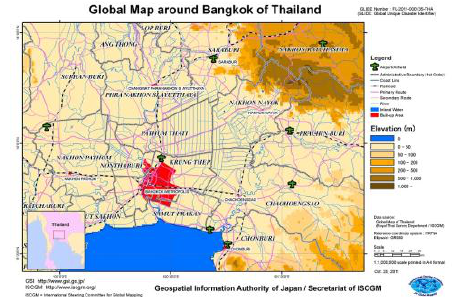
Figure 8: Global Map around Bangkok, Thailand (2011)